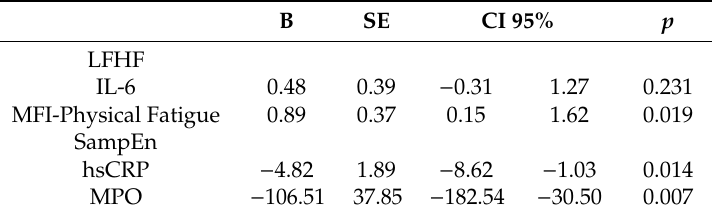
Table 4. Quantile regression analysis evaluating the association between different components of heart rate variability, inflammatory markers, and PROs in women with systemic lupus erythematosus ( n = 55). B SE CI 95% p LFHF IL-6 0.48 0.39 − 0.31 1.27 0.231 0.89